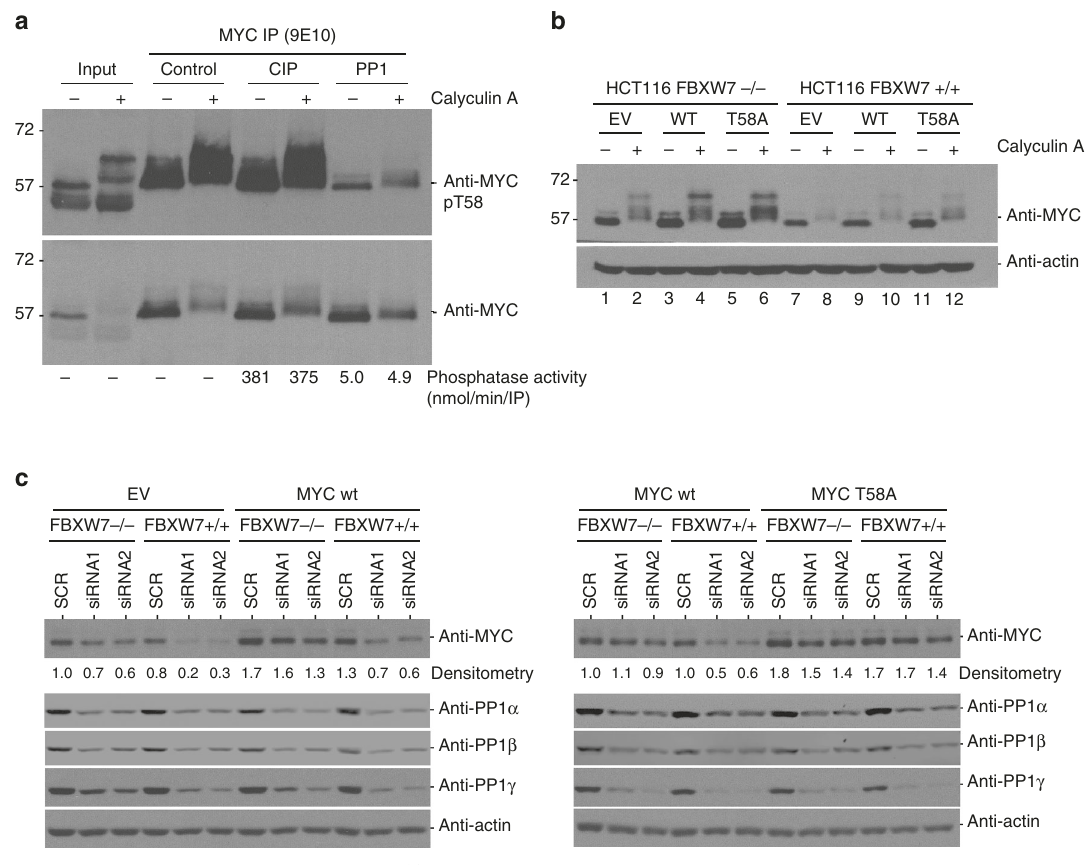
Fig. 4 PP1 dephosphorylates MYC and rescues it from SCF FBXW7 -dependent degradation. a MCF10A cells were treated with Calyculin A (50 nM) or DMSO control for 30 min, lysed, and immunoprecipitated with MYC mouse antibody. The IP was treated with an enzyme control, calf intestinal alkaline phosphatase (CIP) or protein phosphatase 1 (PP1) for 2 h at 30 °C. Total CIP or PP1 enzyme activity in the IP reaction after the 2-h incubation was measured using the substrate p-Nitrophenyl phosphate (PNP). The IP was loaded on a 10% SDS-PAGE, transferred onto nitrocellulose membrane and immunoblotted with MYC pT58 rabbit or MYC rabbit antibody. Shown are representative images of n = 3. b HCT116 FBXW7 knockout ( − / − ) or wild-type ( + / + ) cells expressing inducible ectopic empty vector (EV), wildtype MYC (wt) or MYC T58A (T58A) following 4-hydroxytamoxifen (4-OHT) (48 h) were treated with vehicle control ( − ) or Calyculin A (50 nM) ( + ) for 30 min or c transfected with 10 nM siRNA directed against PP1 α , β , and γ or universal scrambled negative control by calcium phosphate for 48 h and lysed. Protein lysates (20 µ g) were loaded onto 10% SDS-PAGE, transferred onto nitrocellulose membrane and immunoblotted with indicated antibodies. Normalized MYC densitometry values are shown below the MYC blot. Shown are representative images of n =